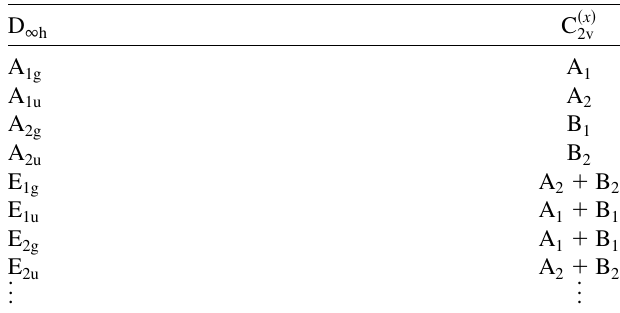
and C (cid:4) x (cid:5) . h 2v